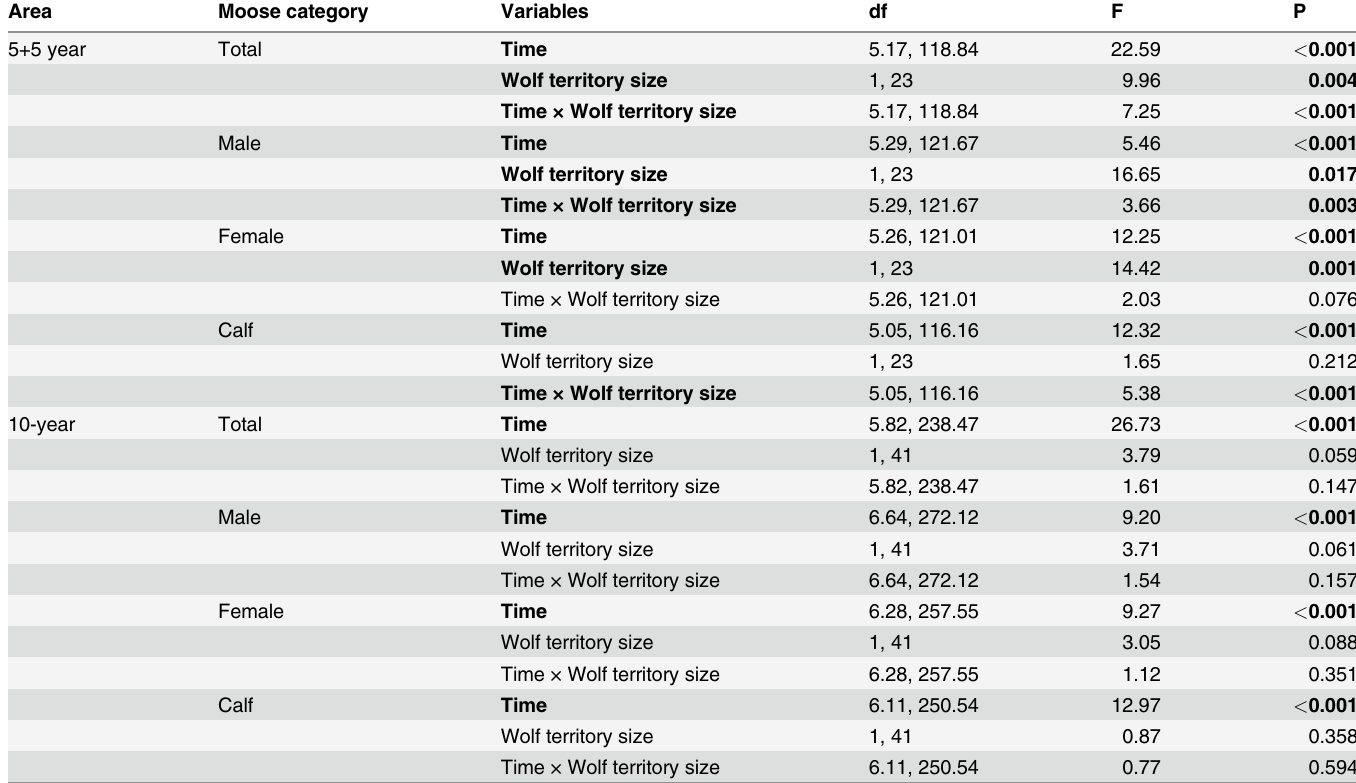
Table 2. Effects of time (ten-year periods) and wolf territory size ( < 1,000 km 2 or > 1,000 km 2 ) on hunter harvest of moose (total number of moose harvested as well as number of males, females and calves). Area Moose category